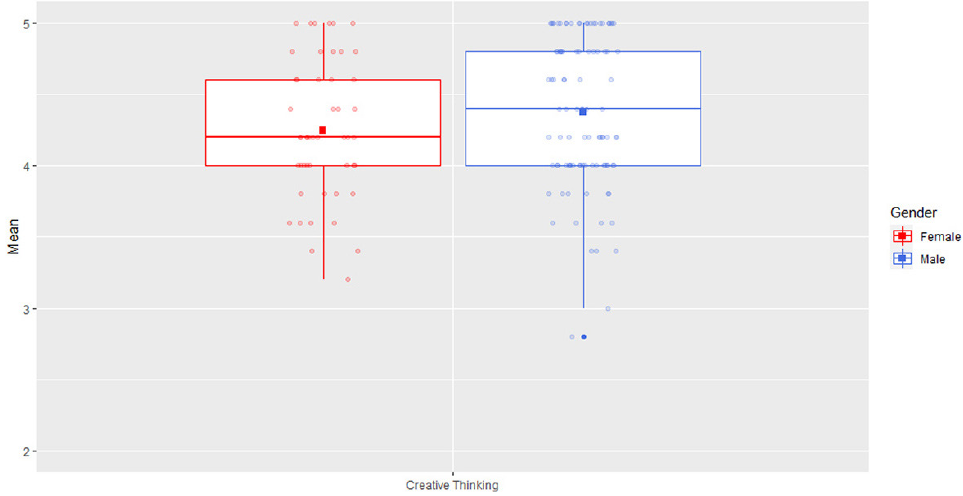
Fig. 7. Boxplot analysis: creative thinking sub-competency by gender